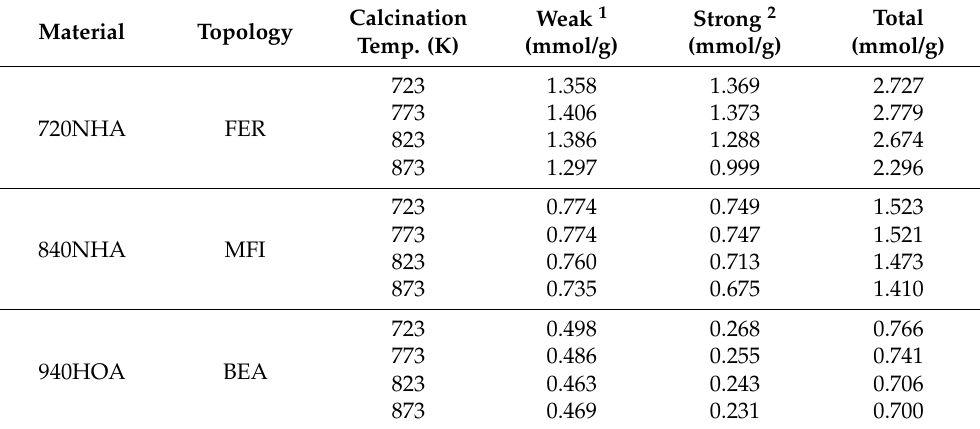
Table 4. Acidic properties of 720NHA (FER), 840NHA (MFI), and 940HOA (BEA) at different calcination